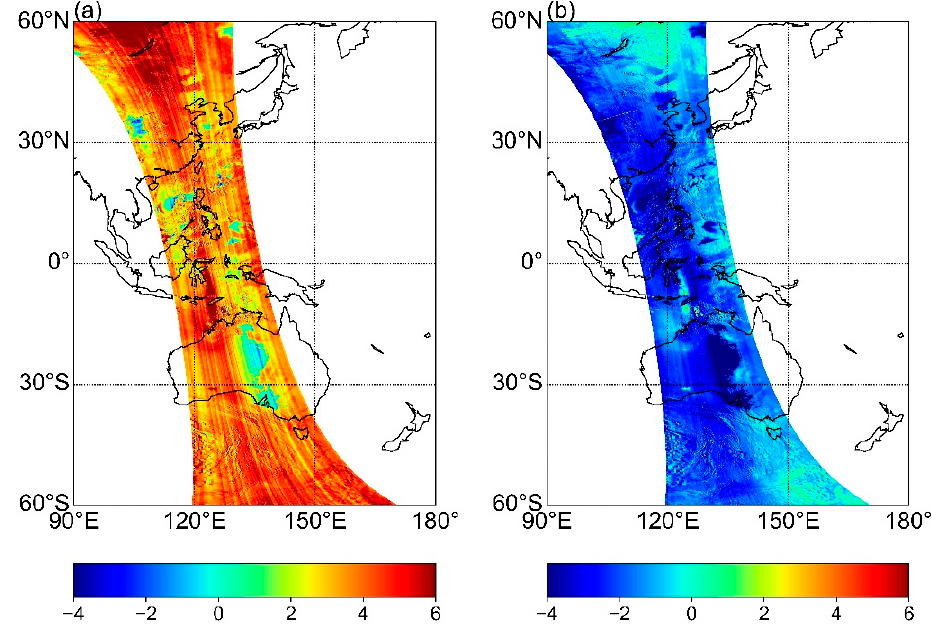
Figure 3. Distribution of the EMI AAI before ( a ) and after correction ( b ) on 5 November 2019.